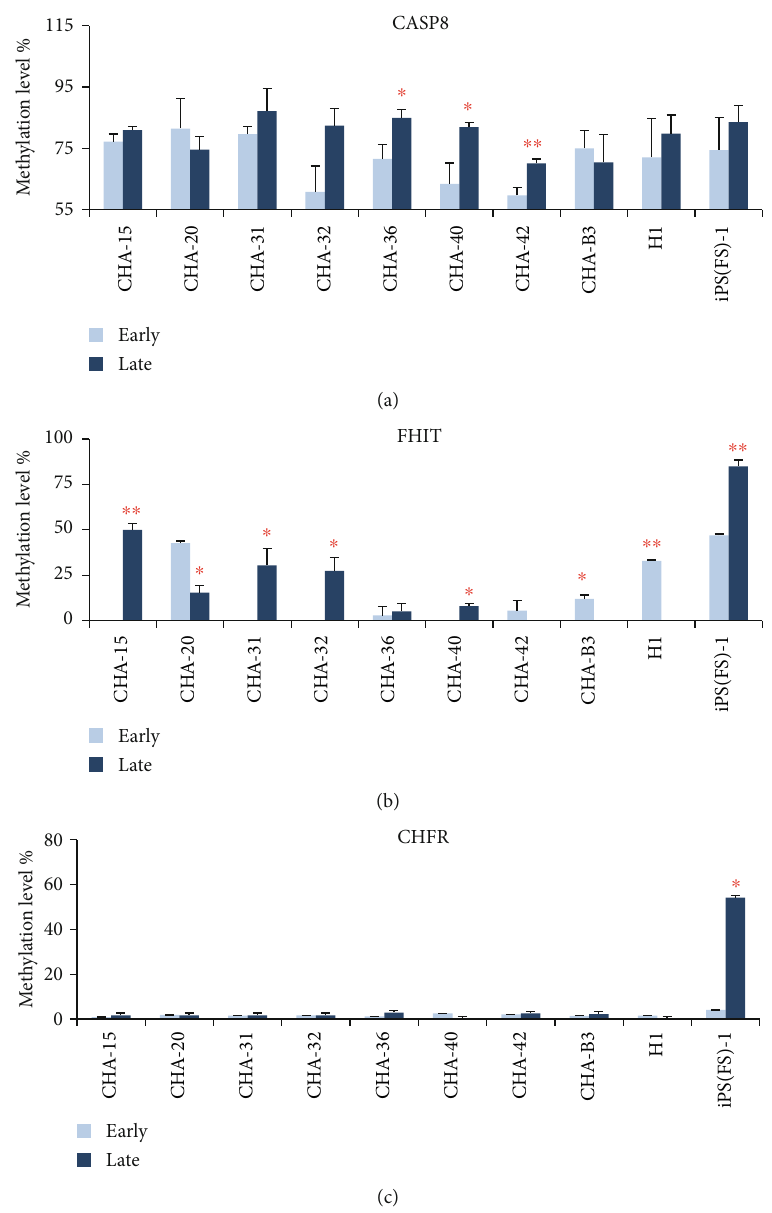
Figure 2: Methylation level of the three genes between early passage and late passage of 10 cell lines using MS-MLPA. Methylation level % of the CASP8 gene (a), FHIT gene (b), and CHFR gene